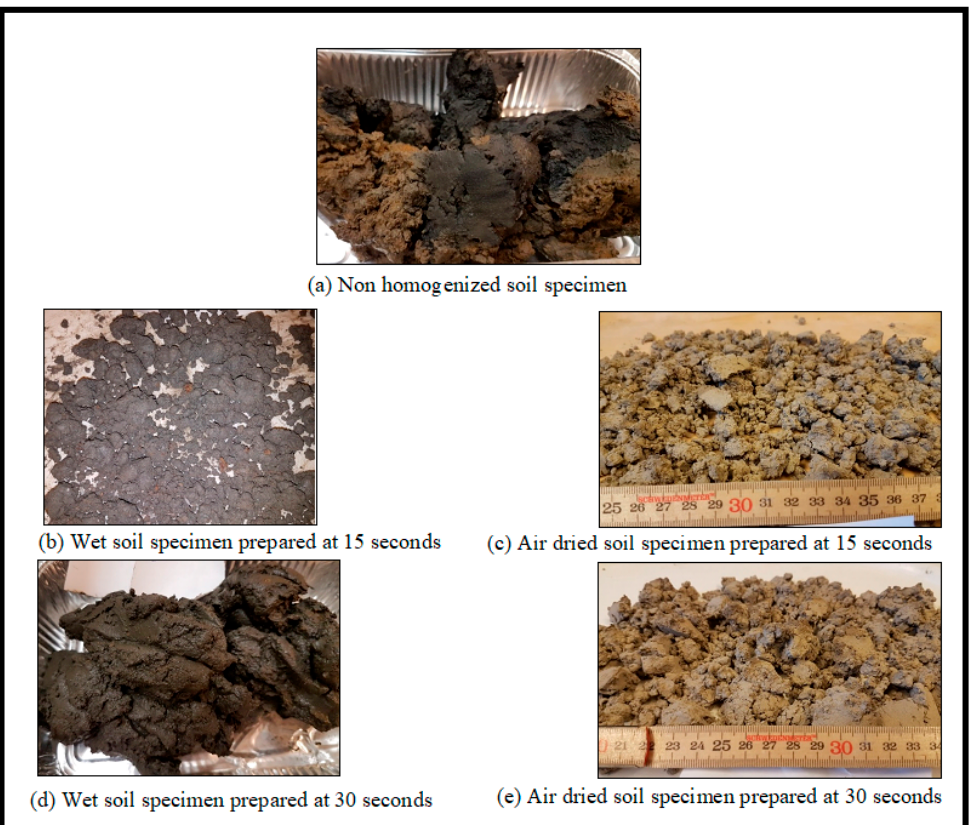
Figure 6. Visual evaluation of Soil 4 before and after disintegration at various times: ( a ) Non homogenized soil specimen; ( b ) Wet soil specimen prepared at 15 seconds; ( c ) Air dried soil specimen